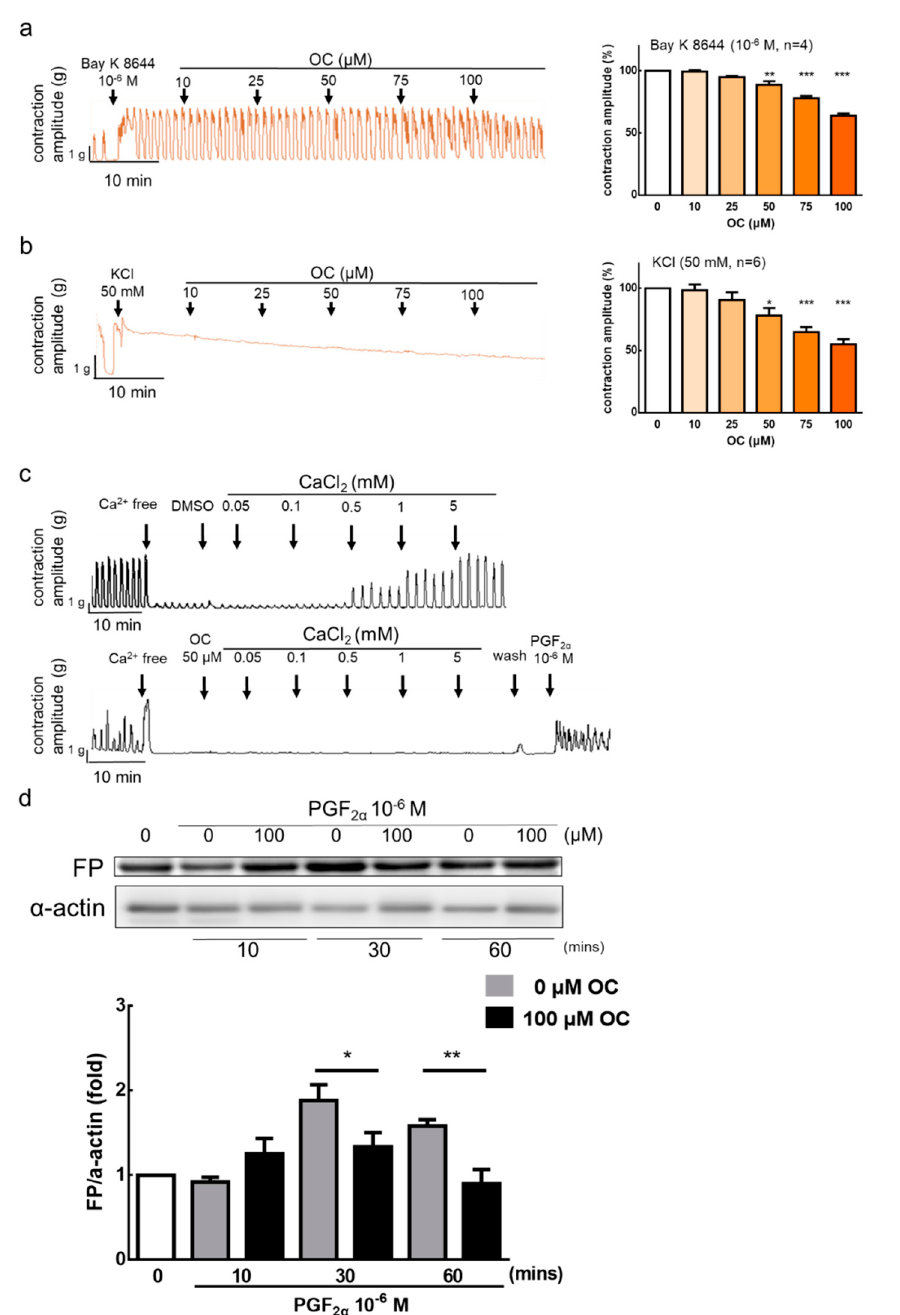
Figure 2. Inhibitory actions of oleocanthal on Ca 2+ -dependent contractile responses. Oleocanthal (OC) (10–100 μ M) was administered after ( a ) Bay K 8644 and ( b ) potassium chloride (KCl). The effect of OC on the mean peak amplitude was calculated. Data are presented as the mean ± standard error of the mean (SEM) ( n = 3–6). * p < 0.05, ** p < 0.01, *** p < 0.001 versus 0 μ M. ( c ) Ca 2+ -free medium containing the vehicle (0.2% dimethyl sulfoxide (DMSO)) or OC 50 μ M for 60 min, and calcium (0.05–5 mM) was then cumulatively applied to trigger muscle contraction. We determined the cytotoxicity of oleocanthal by removing the oleocanthal and washing the tissue with Krebs’ solution, then reanalyzing the tissue in the presence of a stimulus (10 − 6 M prostaglandin F2 α (PGF2 α )). ( d ) PGF2 α receptor protein expression was set at different time points in rat uterus by treatment with oleocanthal (100 μ M). Data are presented as the mean ± standard error of mean (SEM) ( n = 5). * p < 0.05, ** p < 0.01, *** p < 0.001 versus vehicle group. FP: Prostaglandin F receptor